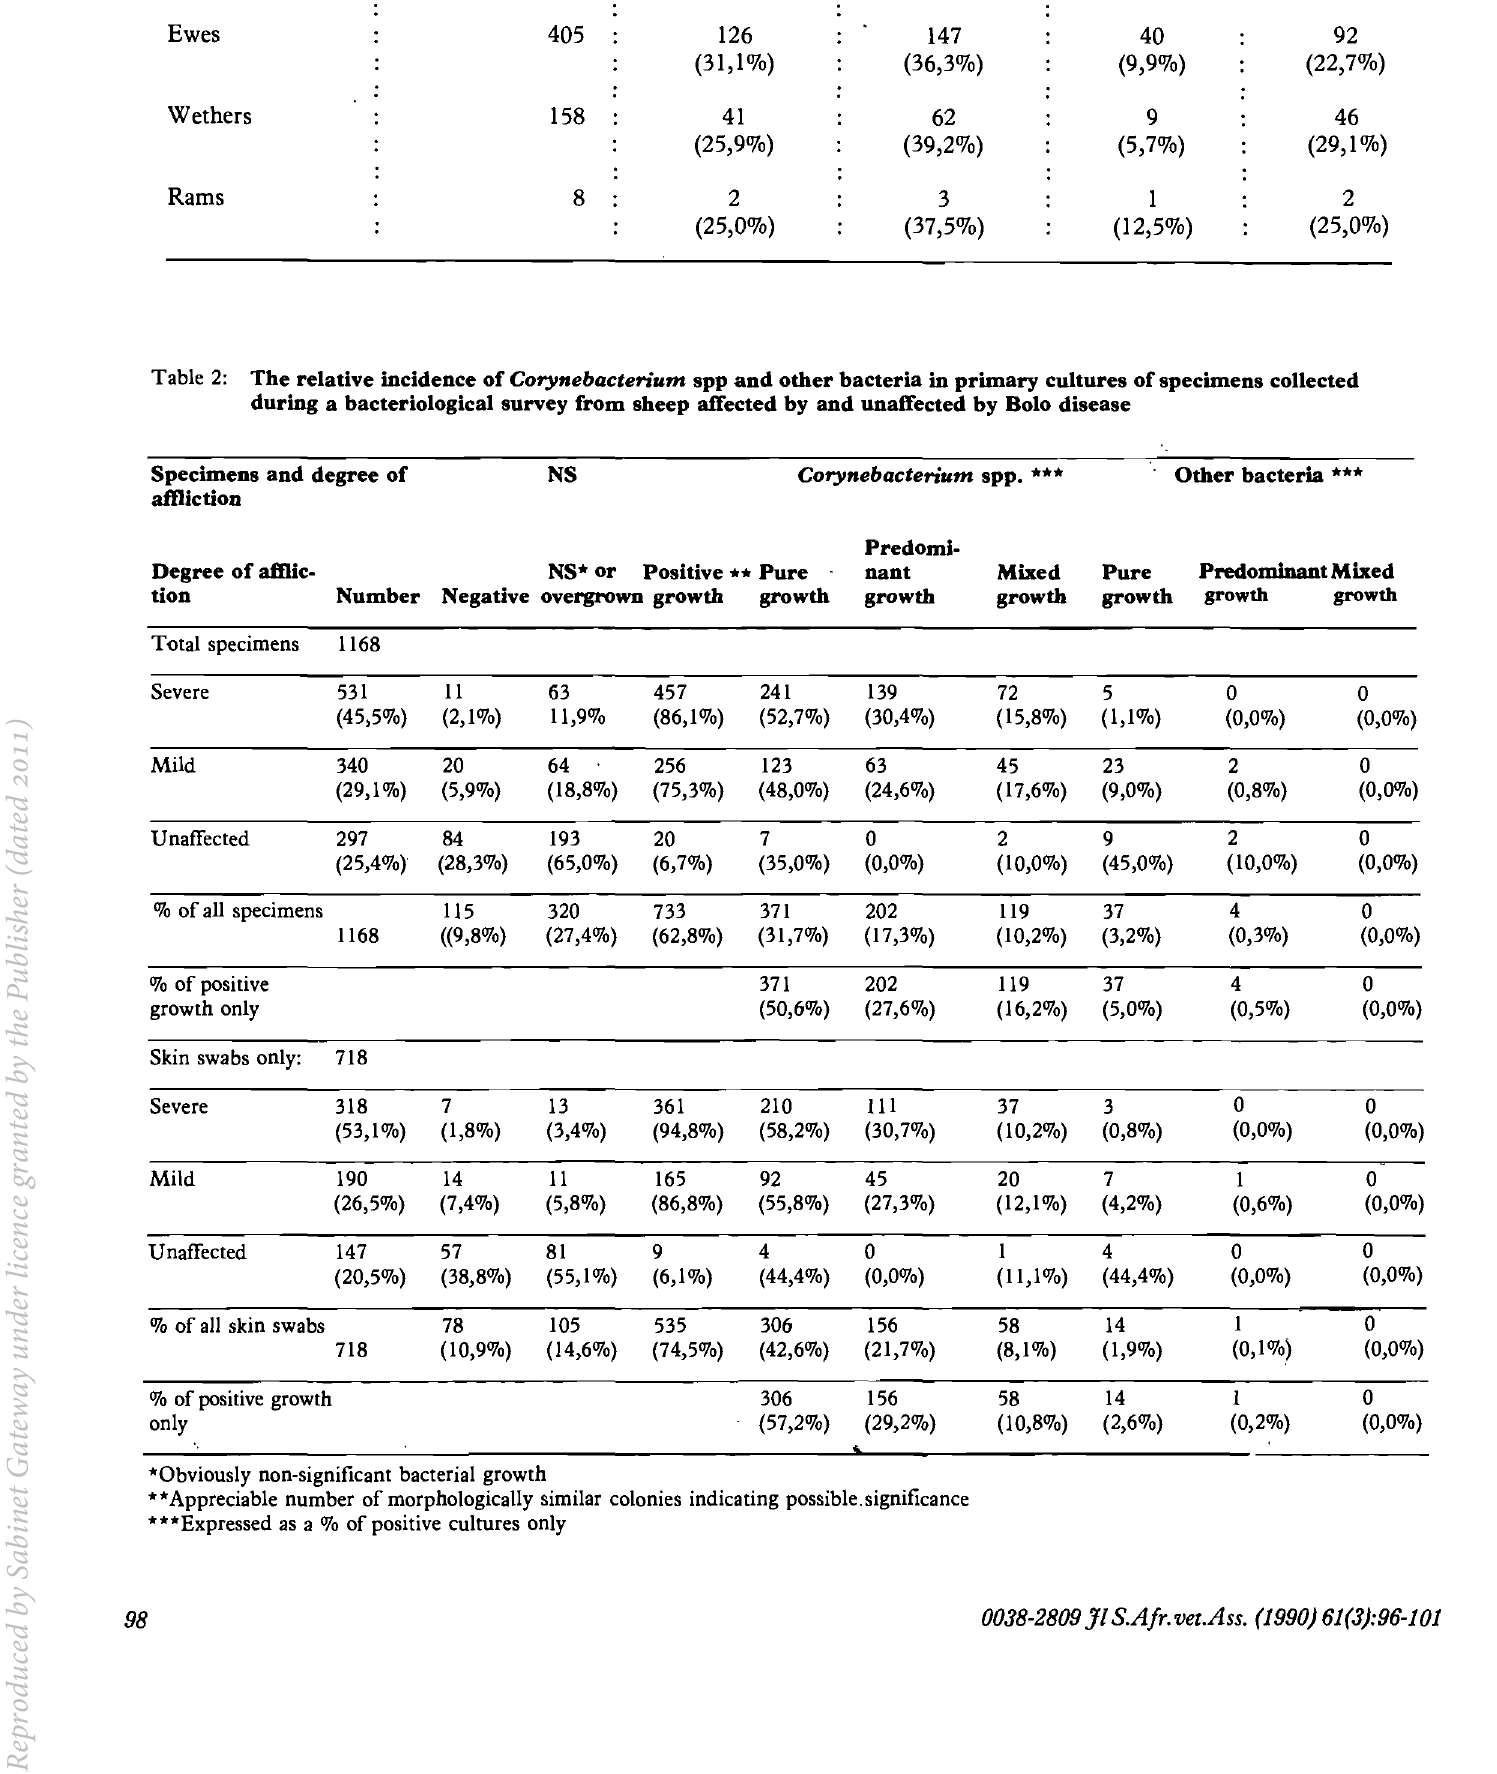
Table 2: The relative incidence of Corynebacterium spp and other bacteria in primary cultures of specimens collected during a bacteriological survey from sheep affected by and unaffected by Bolo disease Specimens and degree